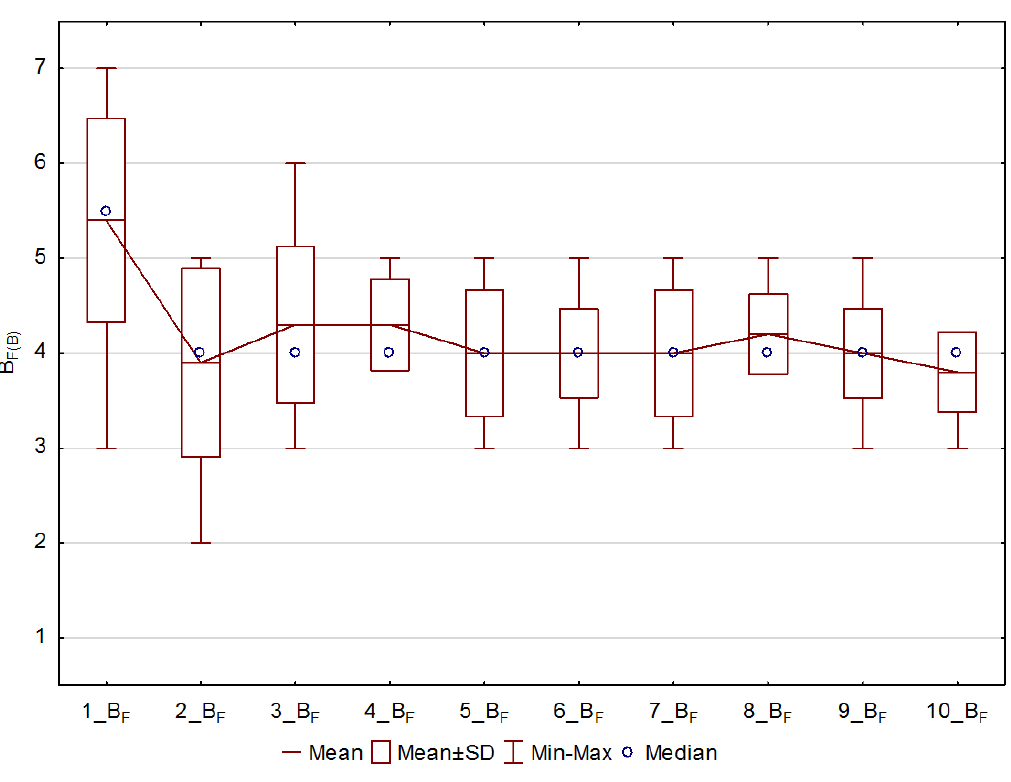
Figure 15. Floor brightness perception for group B.